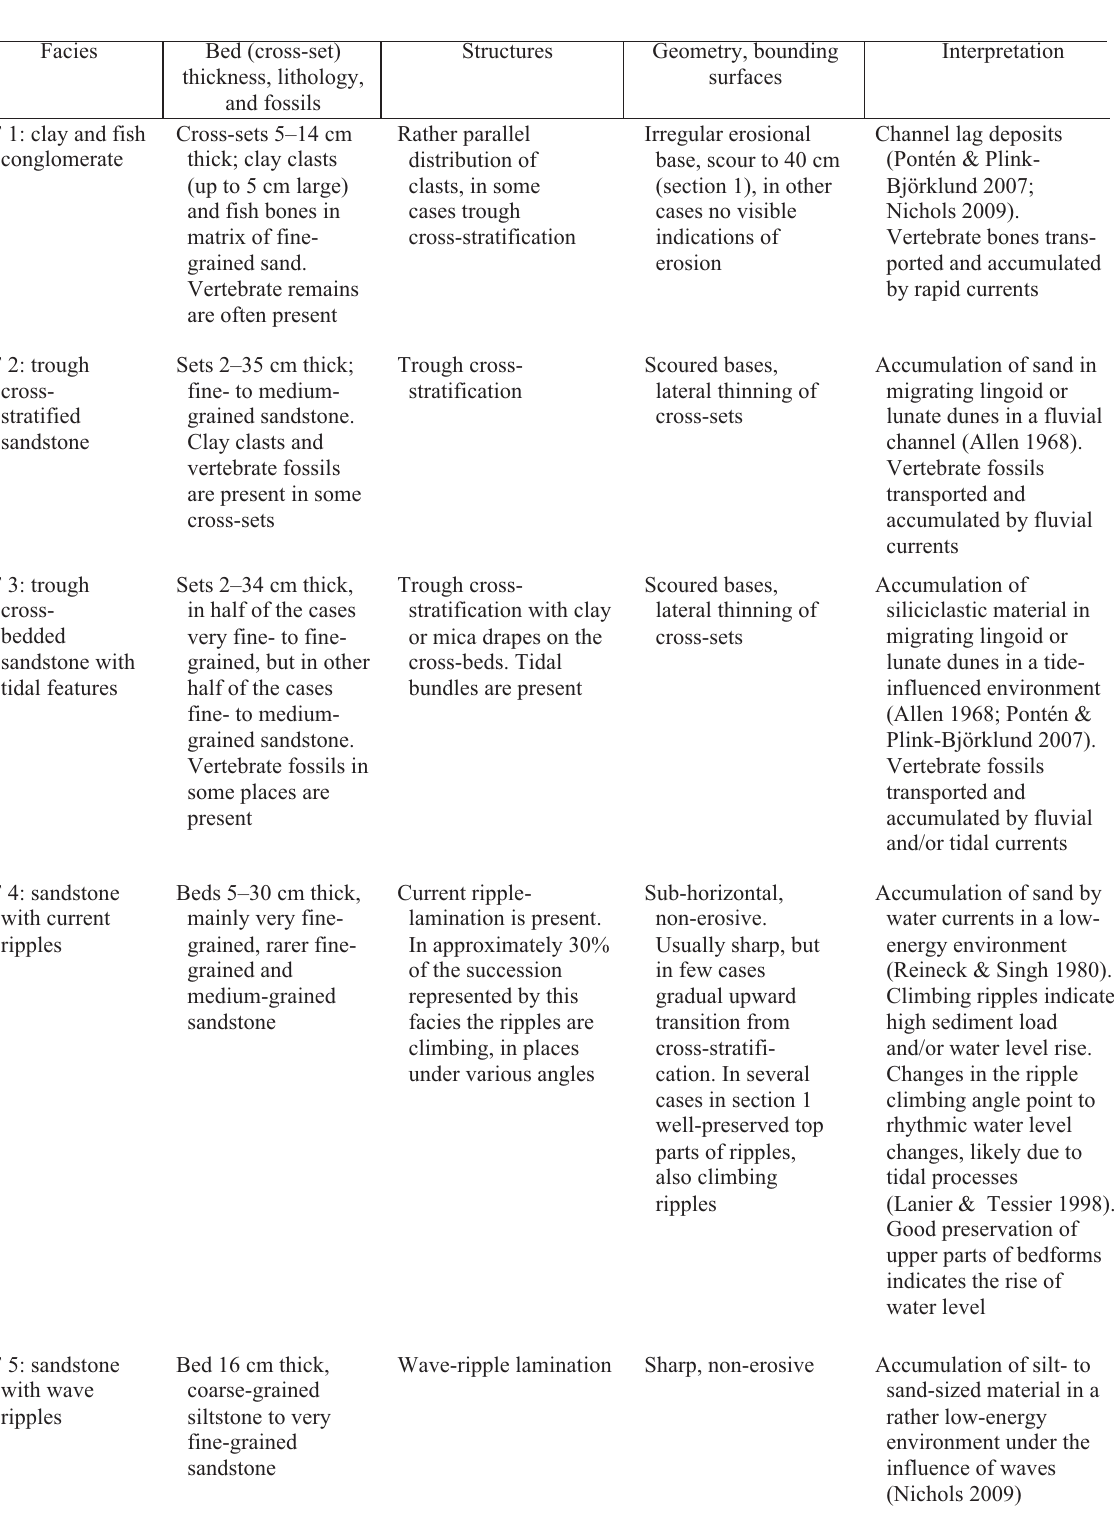
Table 1. Facies distinguished in the Ogre Formation, Gurova